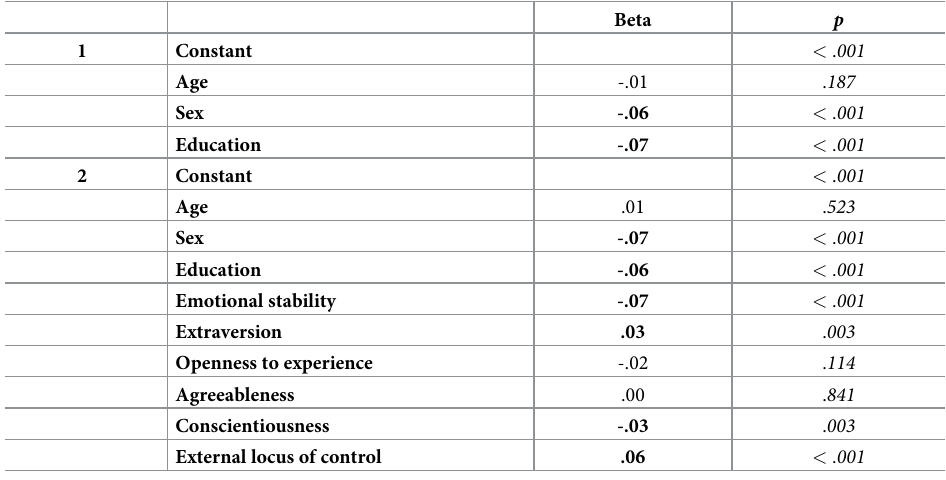
Table 2. Predicting problem gambling from sociodemographic and personality